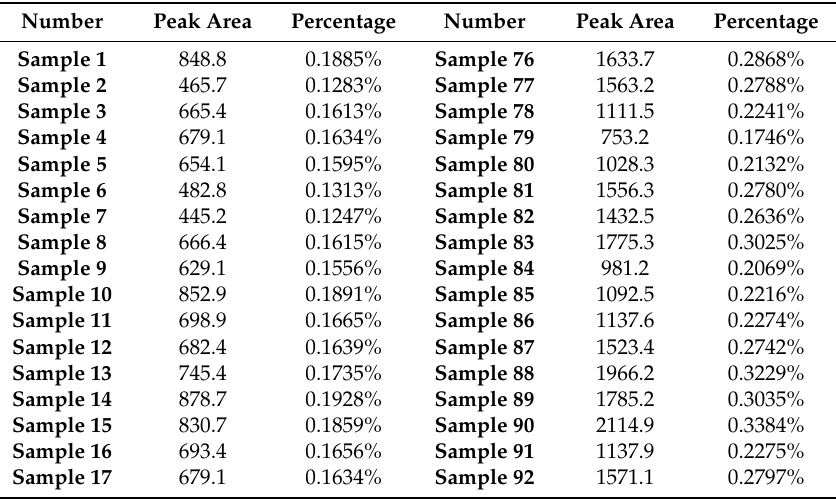
Table 2. Cimicifuga Content Determination Results (n = 150).